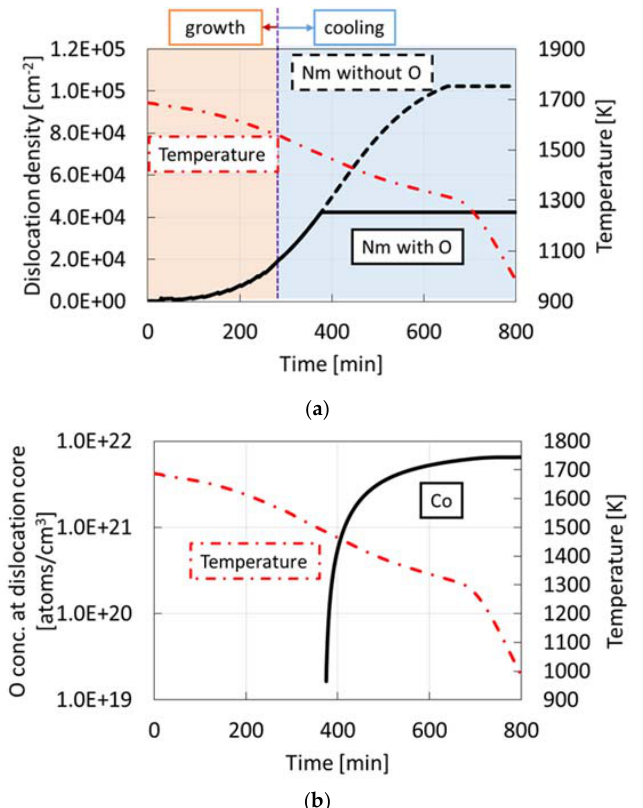
Figure 6. Time ‐ dependent temperature, dislocation density ( a ) and oxygen concentrations ( b ) at point Q during the crystal growth and cooling processes.